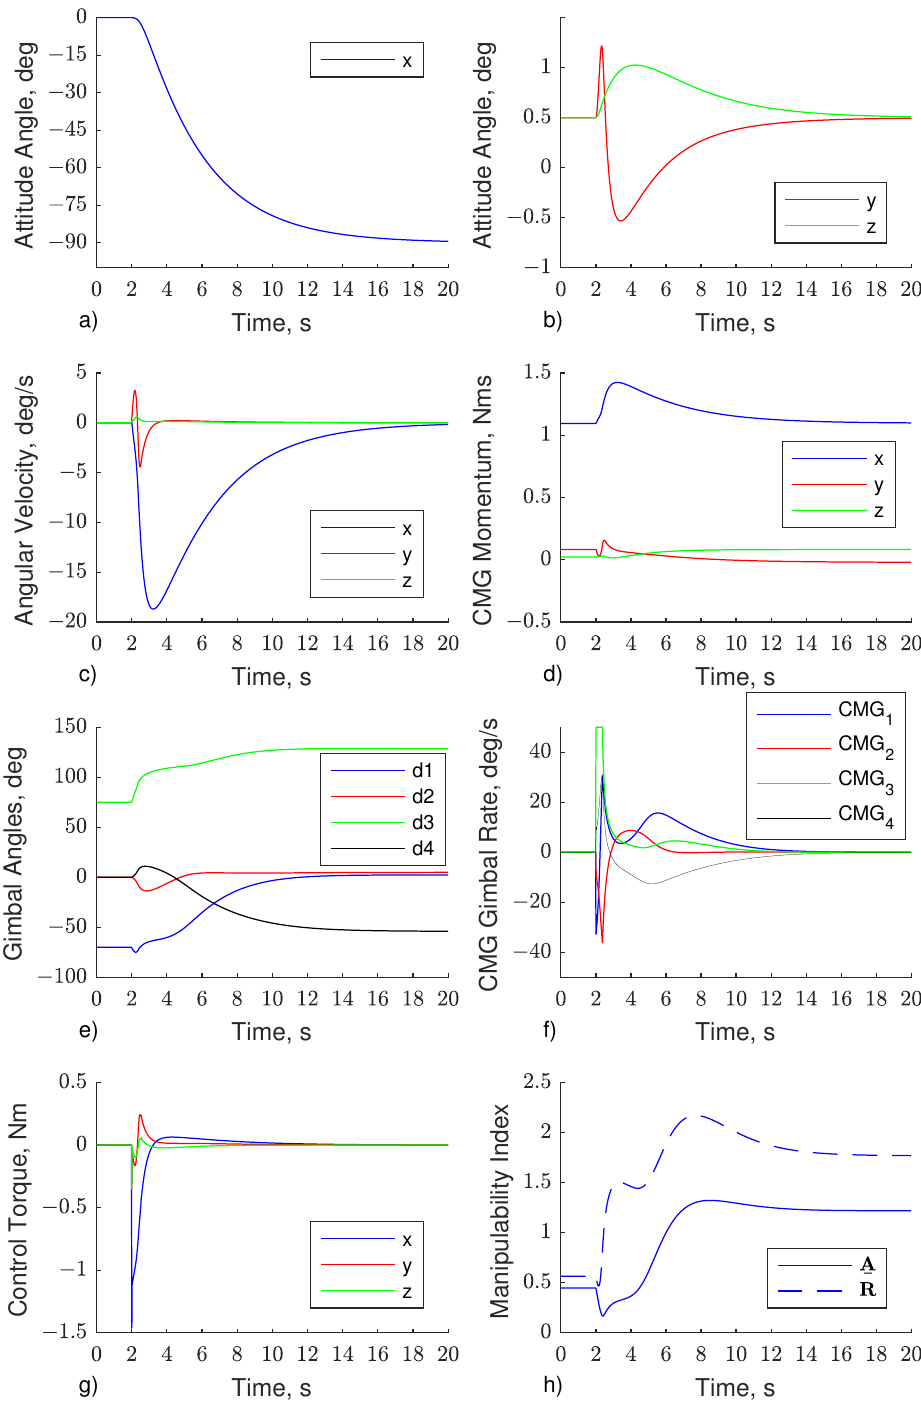
Figure 7. Results derived using the gimballed control moment gyroscope (GCMG) model. ( a ) Attitude angle in x , ( b ) Attitude angle in y , z , ( c ) Angular velocity, ( d ) CMG momentum, ( e ) Gimbal angles, ( f ) Gimbal rates, ( g ) Control torque, ( h ) Manipulability